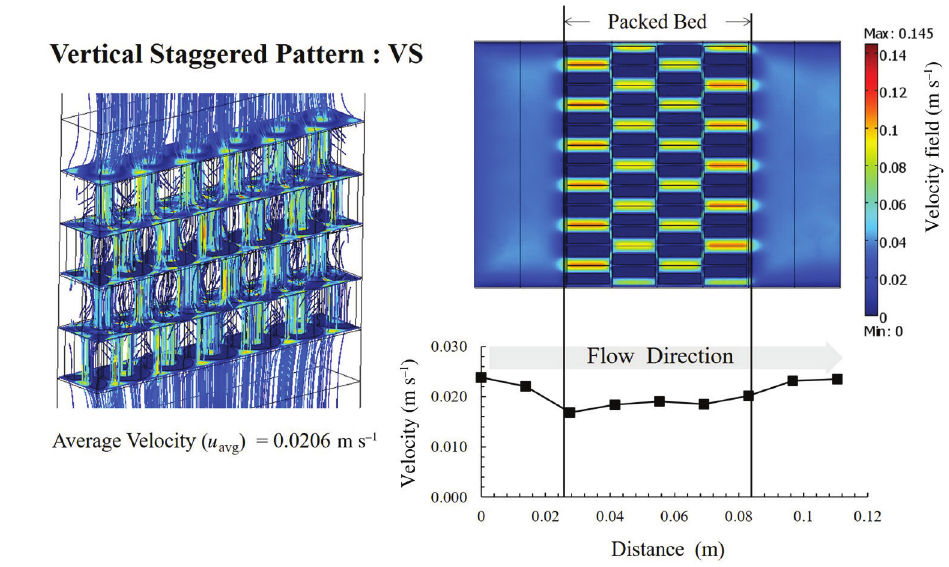
Fig. 4 – Total velocity distribution of VS